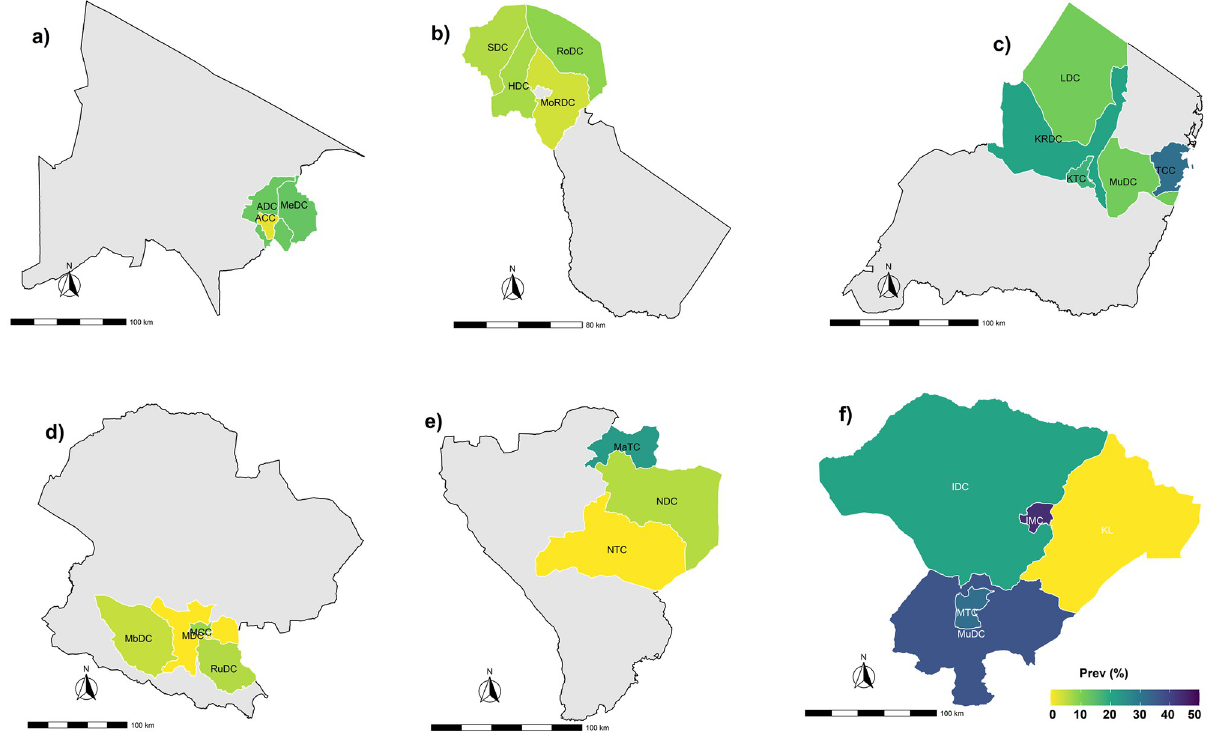
Fig 2. Geographic mapping of leptospirosis distributions and hotspots in 24 districts of study across six regions from two economically important dairy zones of Tanzania. The northern zone ( a , b , and c ) and southern zone ( d , e , and f ). a) Arusha region consisting of Arusha City Council (ACC), Meru District Council (MeDC), Arusha District Council (ADC), b) Kilimanjaro region consisting of Rombo District Council (RoDC), Moshi District Council (MoRDC), Hai District Council (HDC), Siha District Council (SDC), c) Tanga region consisting of Tanga City Council (TCC), Muheza District (MuDC), Korogwe District (KRDC), Korogwe Town Council (KTC), Lushoto District (LDC), d) Mbeya region consisting of Mbeya District Council (MDC), Mbeya City Council (MCC), Mbozi District Council (MbDC), e) Njombe region consisting of Njombe District Council (NDC), Makambako Town Council (MaTC), Rungwe District Council (RuDC), Njombe Town Council (NTC) and f) Iringa region consisting of Iringa District Council (IDC), Iringa Municipal Council (IMC), Mafinga Town Council (MTC), Mufindi District Council (MuDC). Map source: data shape file for Tanzania map at all levels downloaded from